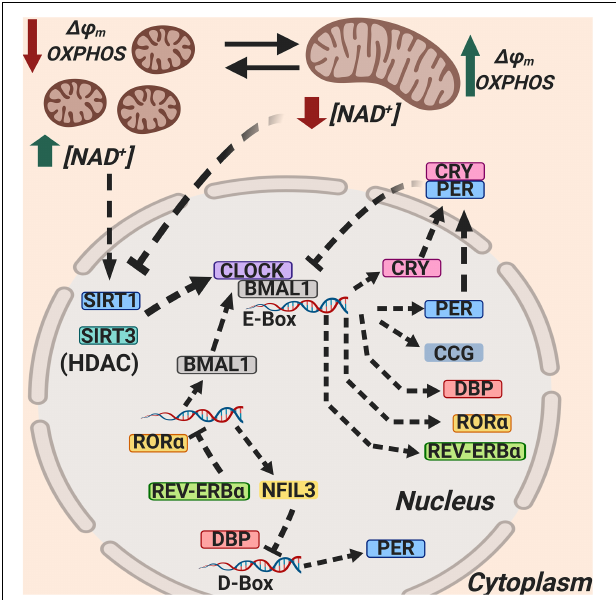
FIGURE 1 | Mitochondria regulate circadian rhythmicity through NAD + production, SIRT1 and SIRT3 activation, and mitochondrial dynamics. The Sirtuin 1 (SIRT1) and Sirtuin 3 (SIRT3) activity as HDACs is dependent on NAD + , and SIRT1 and SIRT3 counteract CLOCK; NAD + synthesis is dependent on circadian rhythmicity, and this is related to mitochondrial dynamics. NAD + , Nicotinamide adenin dinucleotide (oxidized); SIRT1, Sirtuin 1; SIRT3, Sirtuin 3; BMAL1, Brain and muscle aryl hydrocarbon receptor nuclear translocator-like 1; CLOCK, circadian locomotor output cycles kaput; ROR α , Retinoic acid receptor-related orphan receptor α ; REV-ERB α , Reverse strand of ERBA (REV-ERB α is encoded by the opposite DNA strand of the ERBA oncogene, hence its name); NFIL3, nuclear factor interleukin 3; DBP, D-box binding protein; CRY, Cryptochrome; PER, Period; CCG, Clock-Controlled